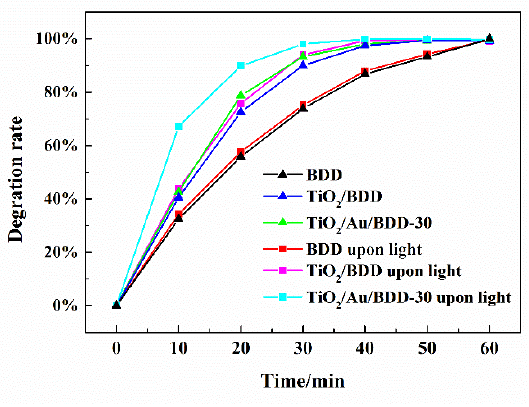
Figure 8. Degradation efficiencies of the simulated wastewater for the various electrodes.